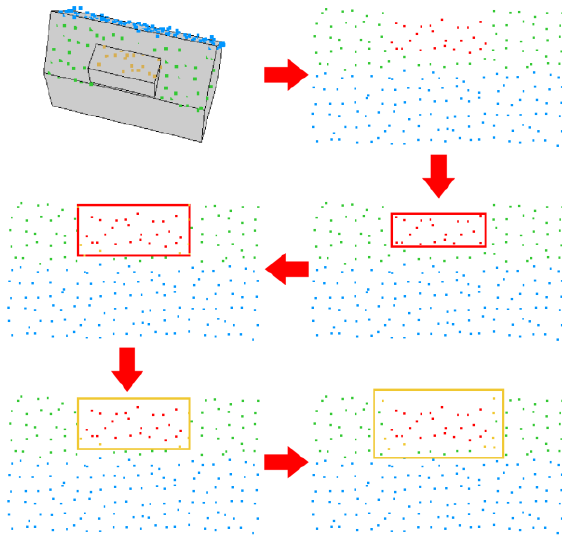
Figure 3. Segmented surface points enriched with virtual points (red). Unsegmented surface points are colorized in black.